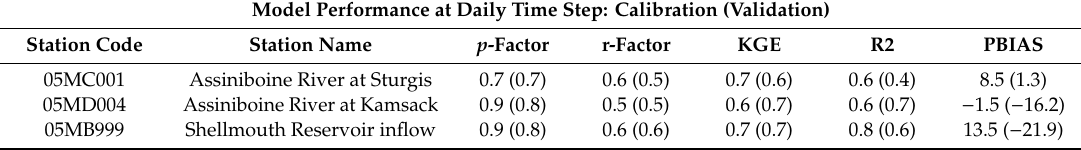
Table 4. Statistical measure of baseline model performance: Calibration (1991–2000) validation (2005– 2014).